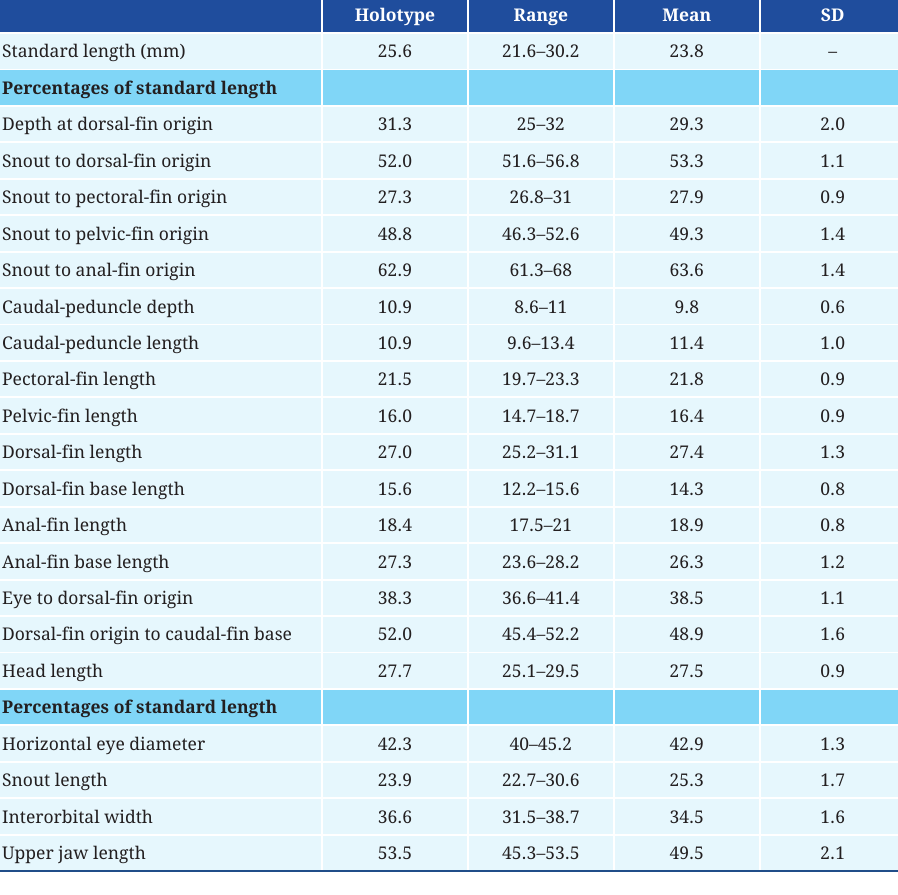
TABLE 1 | Morphometric data of Astyanax nobre . Range includes the holotype and 30 paratypes. SD = Standard deviation.